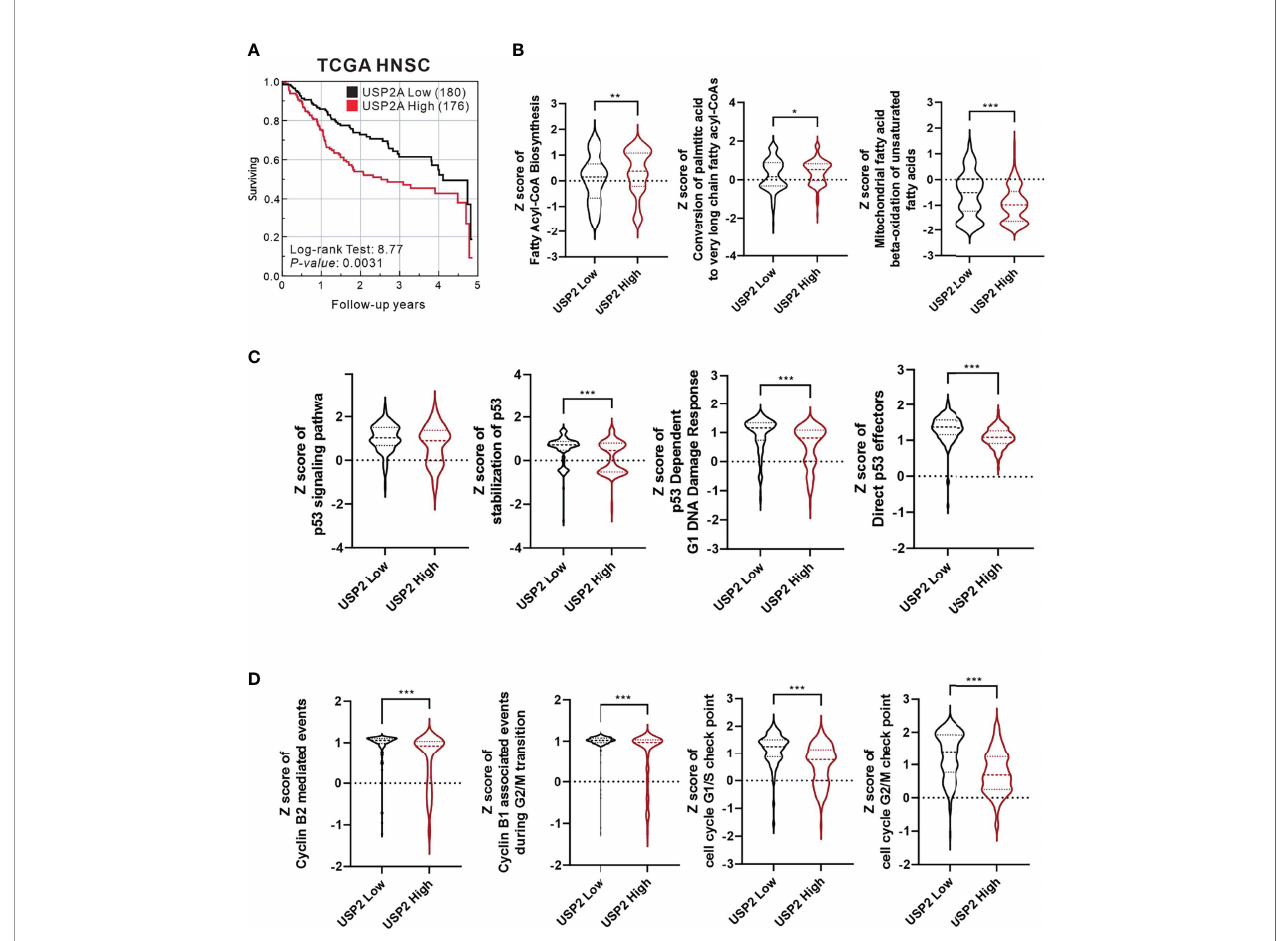
FIGURE 1 | Analysis of The Cancer Genome Atlas Head-Neck Squamous Cell Carcinoma (TCGA-HNSC) data collection. The relationship between USP2a expression levels and (A) survival rate analyzed using the log-rank test; (B) fatty acid synthesis; (C) p53 function; (D) cell cycle progression. For all statistical analyses, unpaired t-tests were used, and results were considered signi fi cant at p < 0.05. * p < 0.05, ** p < 0.01, and *** p <